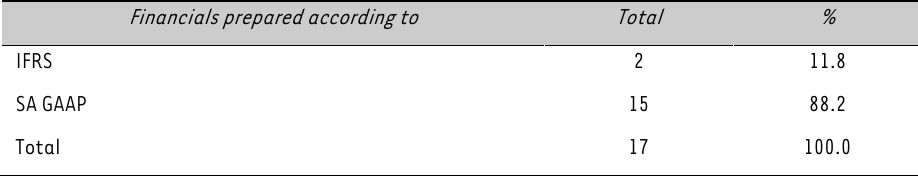
TABLE 5: Accounting